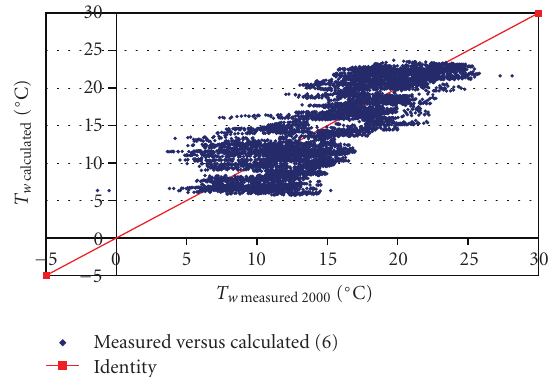
Figure 5: Comparison between measured and estimated data (6), correlation coe ffi cient r Tw , Tw 1 = 0 .